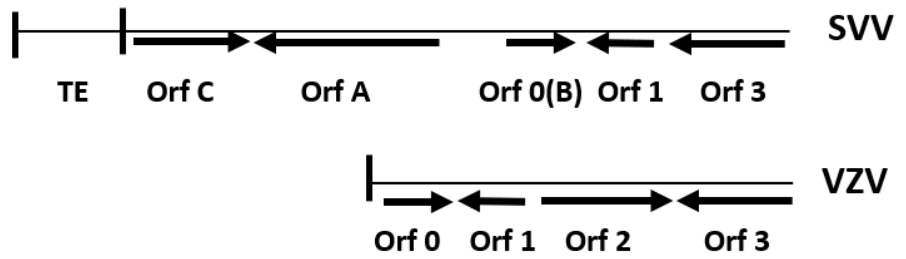
Figure 3. The left ends of the SVV and VZV genomes. SVV and VZV ORFs are designated by arrows indicating the site on each DNA strand. SVV DNA includes a terminal element (TE) but does not have an ORF 2. VZV DNA does not include a TE, ORF A, or ORF C. Vertical lines indicate TRL sequences.